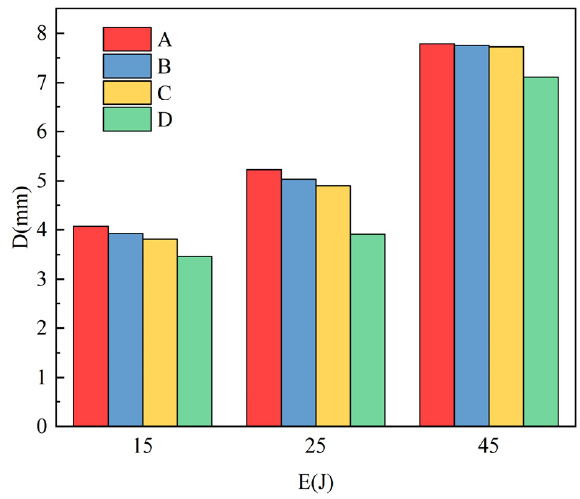
Figure 17. Impact pit depth of different laminates.